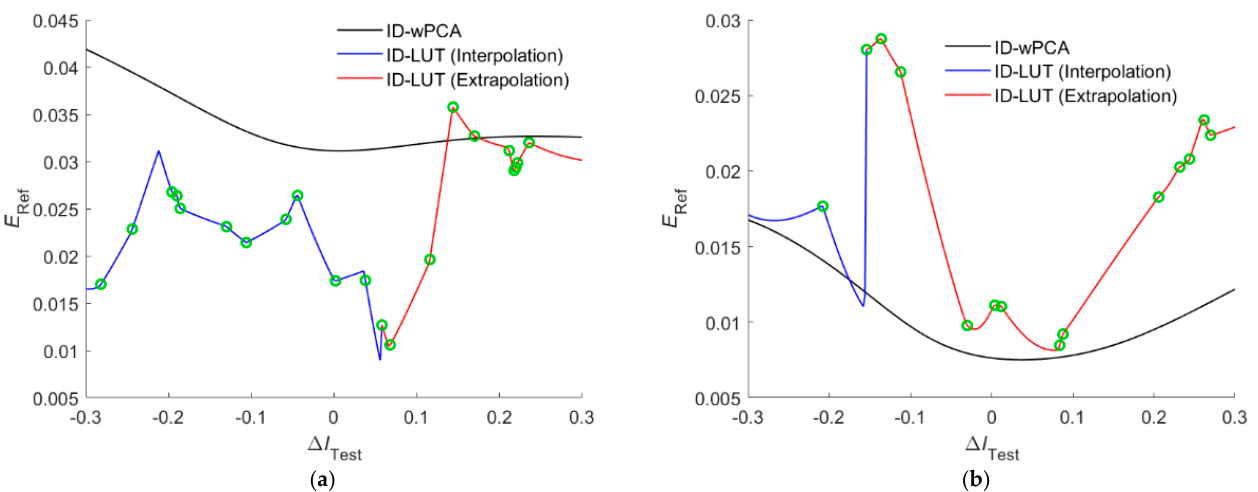
Figure 9. RMS error E RefRec value versus the Δ I Test value using the ID-LUT and ID-wPCA methods. The camera is the RGBF camera. The test samples are prepared using the ( a ) 5Y 8.5/8 and ( b ) 10P 7/8 color chips. Green circles show the change of the located simplex as the Δ I Test value increases.